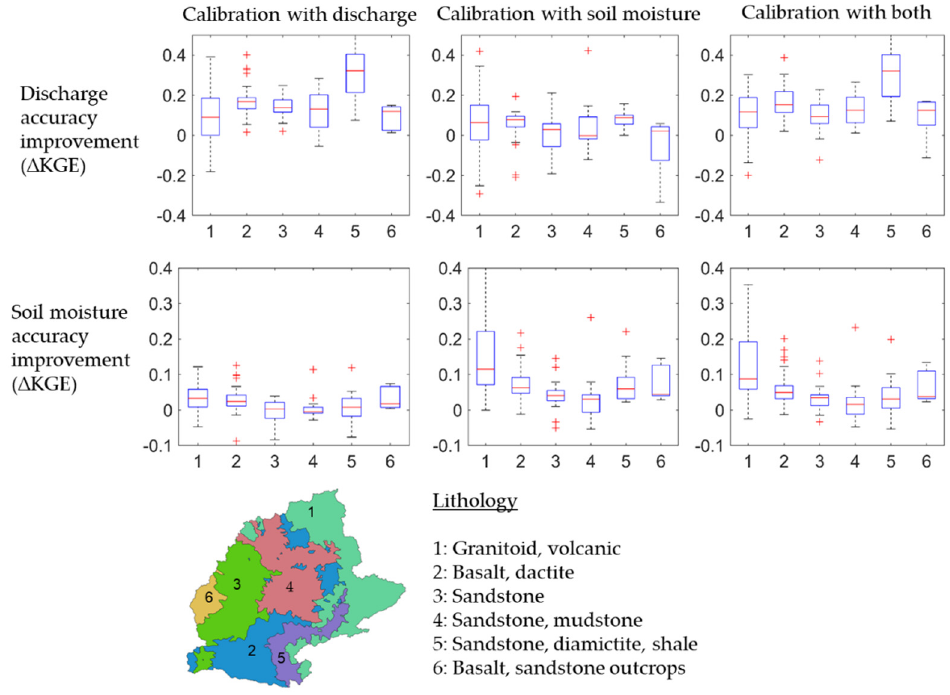
Figure 6. Assessment of accuracy improvements for discharge and soil moisture parameters for the six lithology types and three calibration scenarios (with discharge, with soil moisture, and with both). Each boxplot refers to one lithology type.